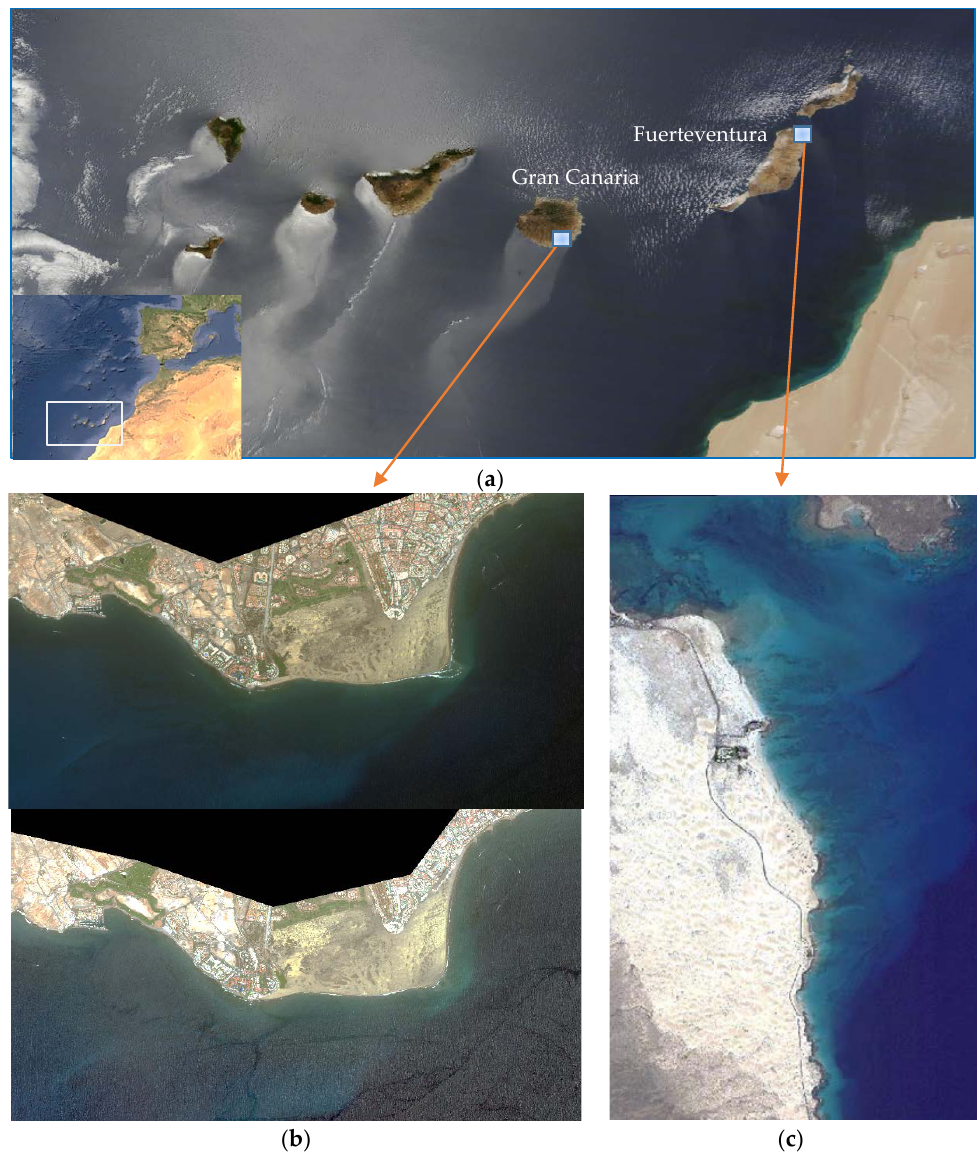
Figure 1. ( a ) Location of study areas (Canary Islands) 1 and; ( b , c ) WorlView-2 images of the two Canary Islands singular littoral zones: ( b ) Maspalomas area (Gran Canaria Island), upper : 11 August 2013; lower : 4 June 2015 and; ( c ) Corralejo-Lobo Island area (Fuerteventura Island) 28 October 2010.